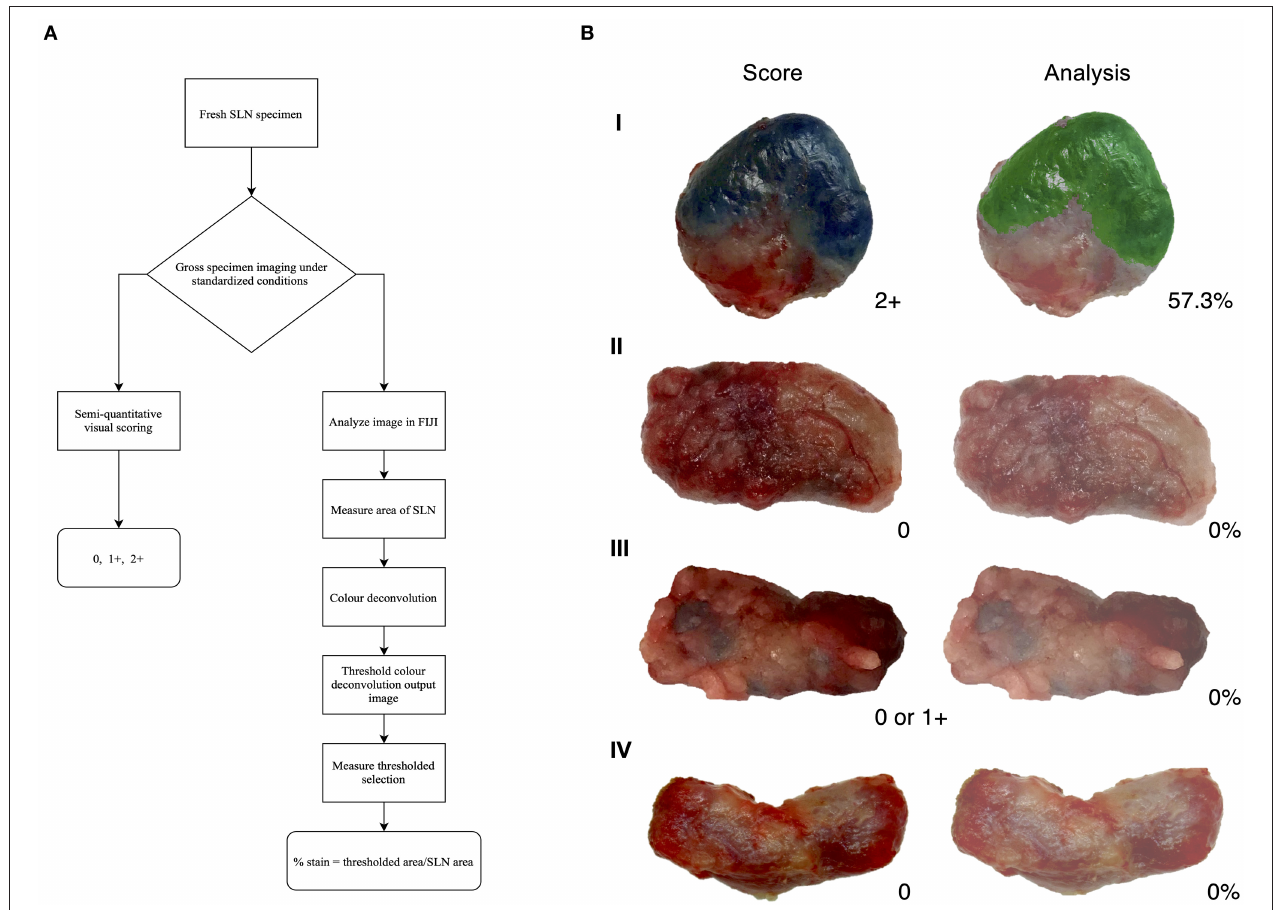
FIGURE 1 | Visual assessment and image analysis outcomes. (A) Workflow of assessment for methylene blue stained lymph nodes. (B) Score and analysis of sentinel lymph nodes (SLN). Depicting a positive node (I), a negative node (II), an ambiguous node (III), and a negative control node (IV); all with agreement between score and analysis.